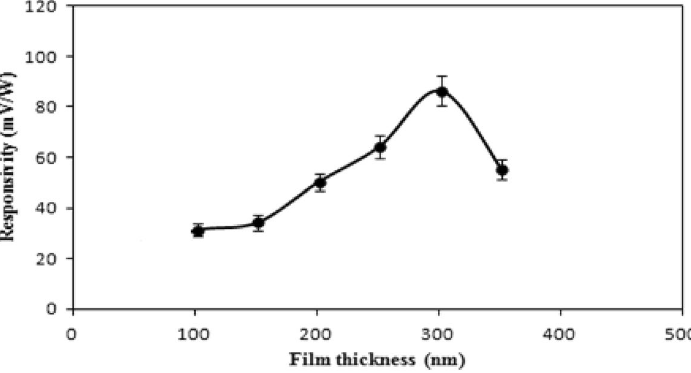
Figure 11. Responsivity of Sb detector for Nd: YAG laser pulse as a function of film thickness.